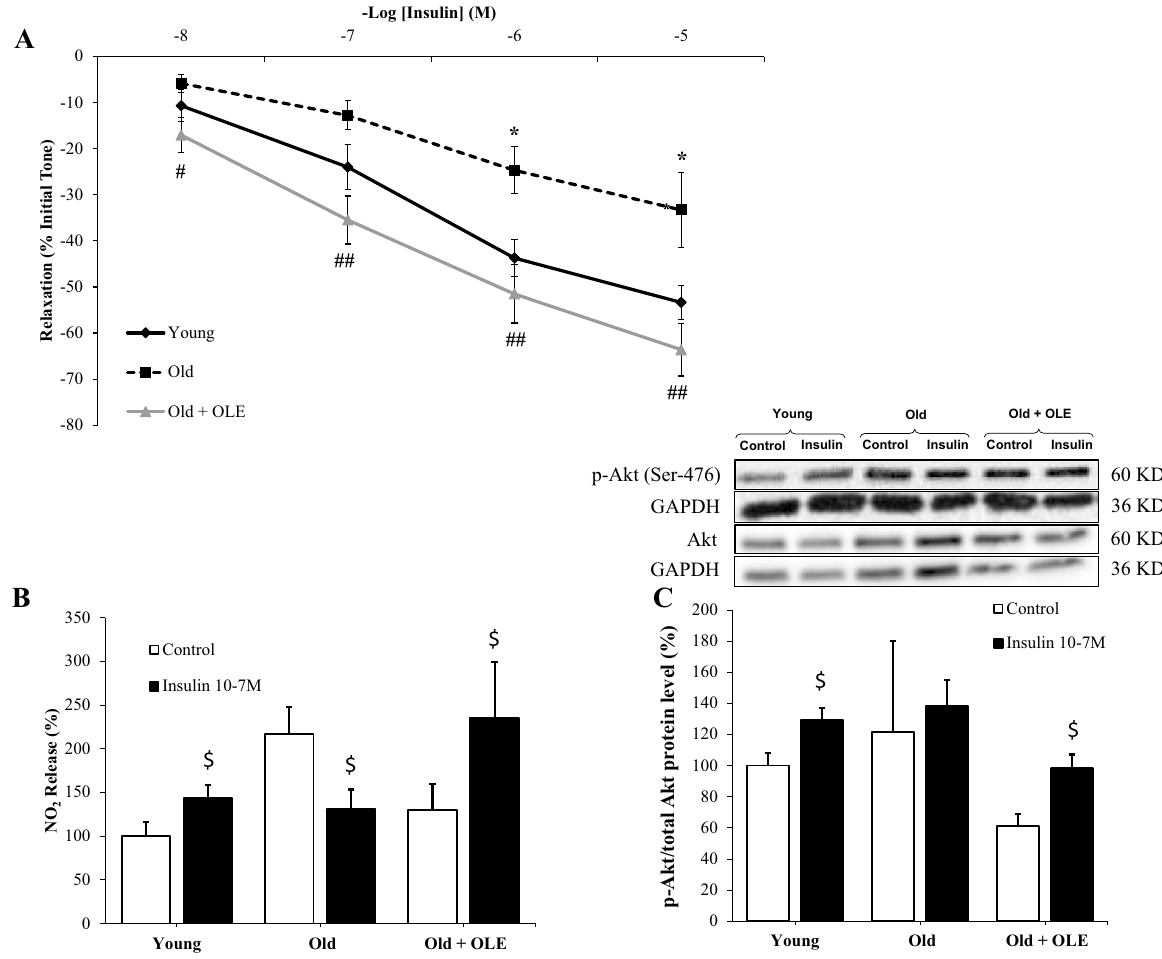
Figure 6. Effects of aging and a 21-day treatment with the OLE on the relaxation response of thoracic aortic segments to insulin ( A ), on the nitrites release from aorta segments to culture medium in presence/absence of insulin (10 −7 M) ( B ), and on the ratio between protein levels of p-Akt and Akt in aorta ( c ). Values are represented as mean ± SEM. * p < 0.05 vs. Young; # p < 0.05 vs. Old; ## p < 0.01 vs. Old; $ p < 0.05 vs.